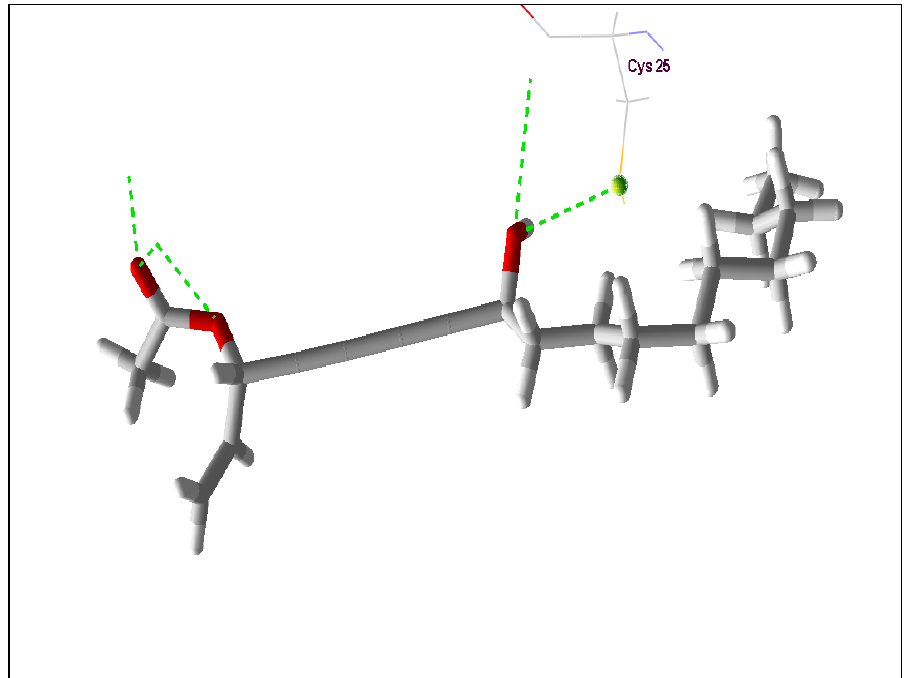
Supplementary Figure 1. Predicted hydrogen bonding between 8-Hydroxylheptadeca- 4,6-diyn-3-yl acetate and active site Cys 25.